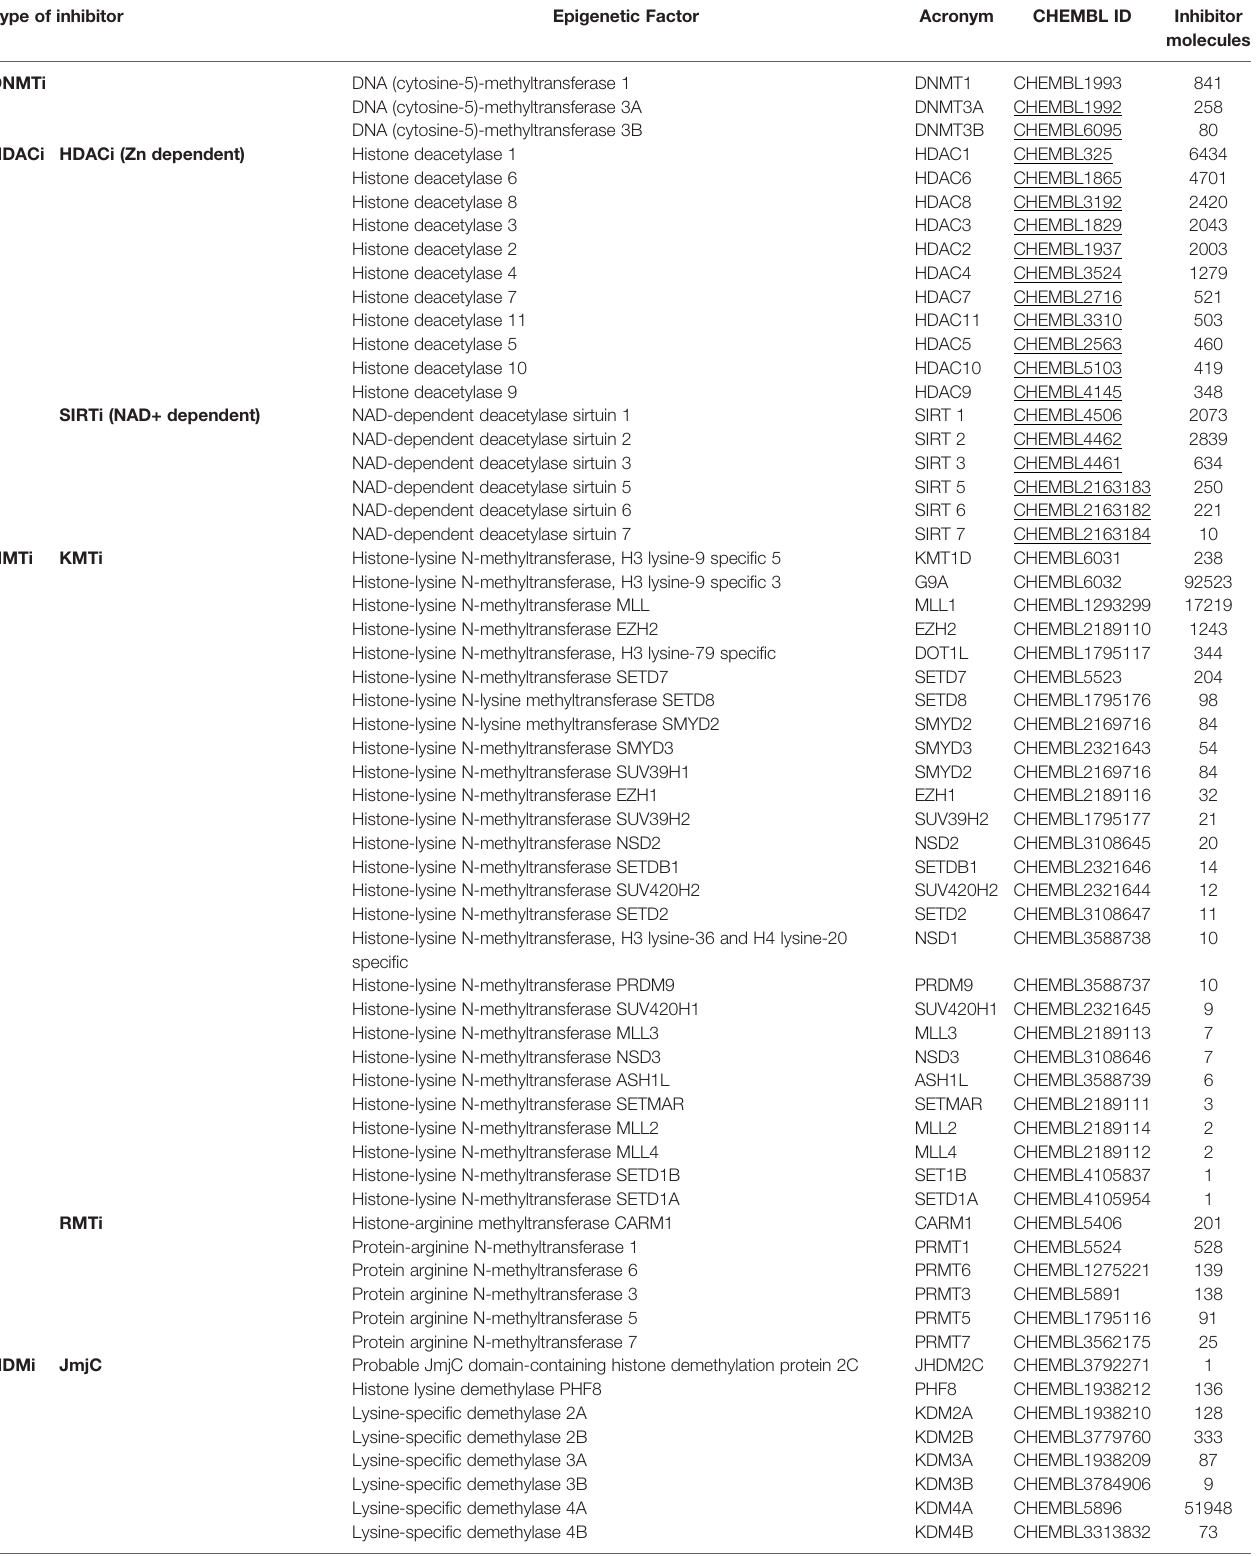
TABLE 1 | Current inhibition assays performed for different epigenetic